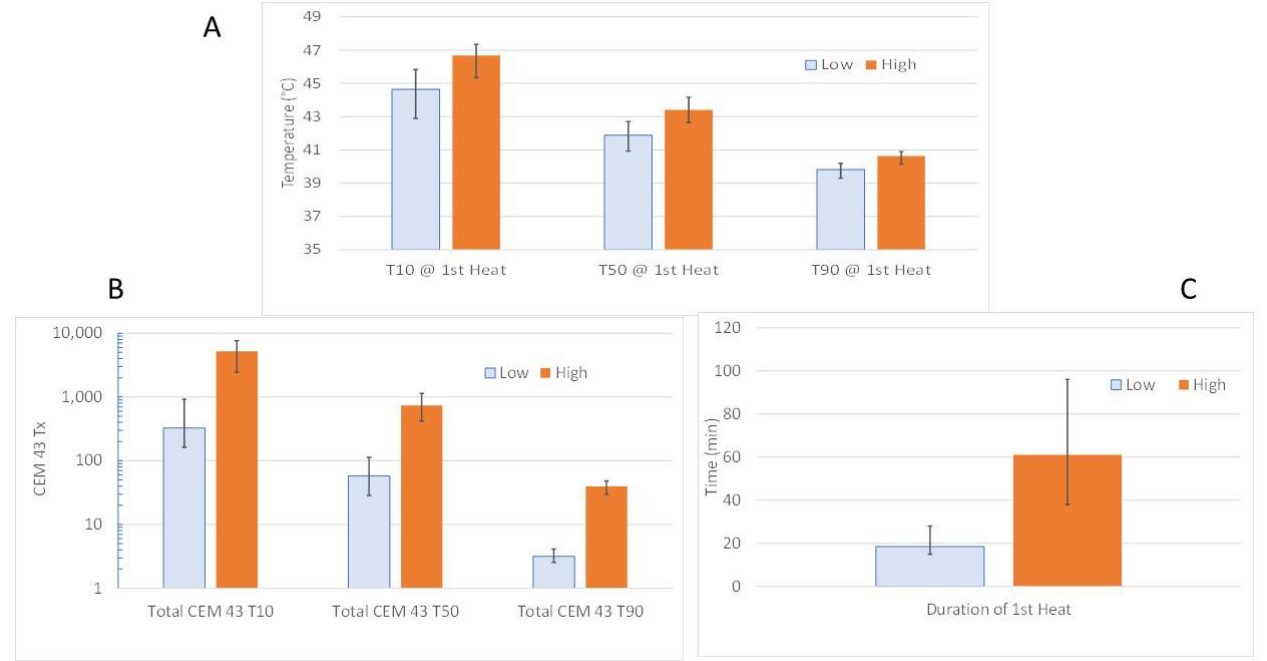
Figure 2. Thermal dose characteristics of thermal dose escalation trial of Thrall et al. [108] ( A ) Comparison of CEM43T 10 , T 50 and T 90 values. The trial was designed to deliver approximately a 20-fold difference in CEM43T 90 between the low and high dose groups. ( B ) To achieve this difference in CEM43T 90 , and CEM43T 10 , T 50 throughout the tumors were higher. ( C ) Heating times were also longer. N = 21 Low dose group; N = 18 High dose group. Data from the subjects for which physiologic data were reported (Lora-Michaels et al. [109]).